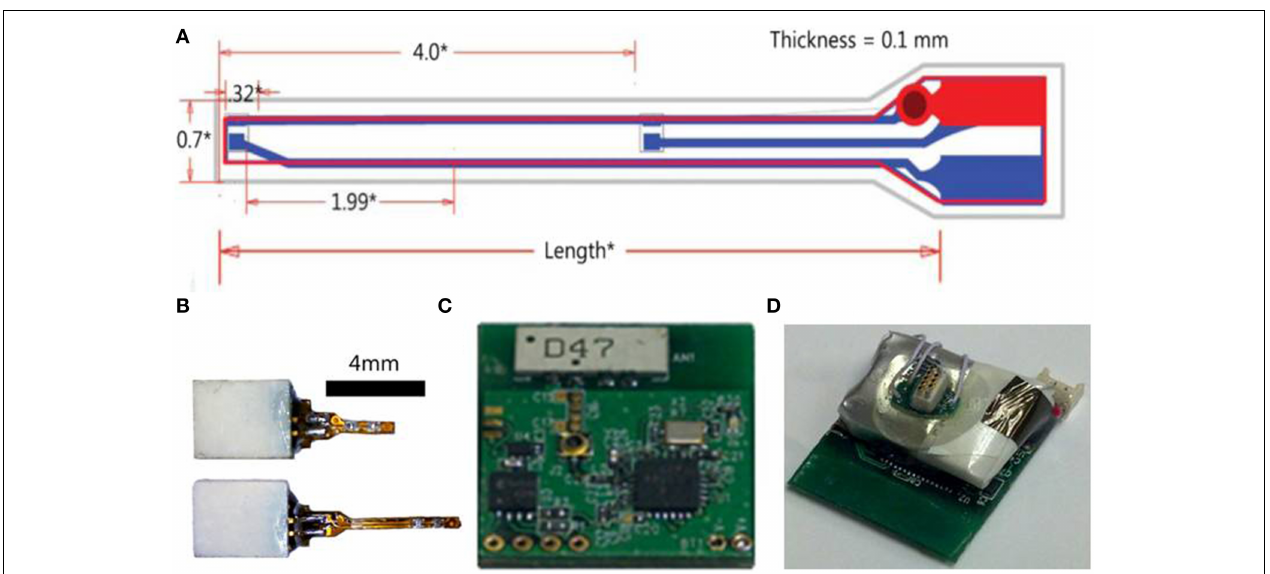
FIGURE 2 | Wireless optogenetic stimulation system with implantable LED. (A) Illustration of LED shank (all measurements in mm). (B) LED implants with connectors. (C) Digital radio PCB. (D) Assembled opto-stimulator PCB.